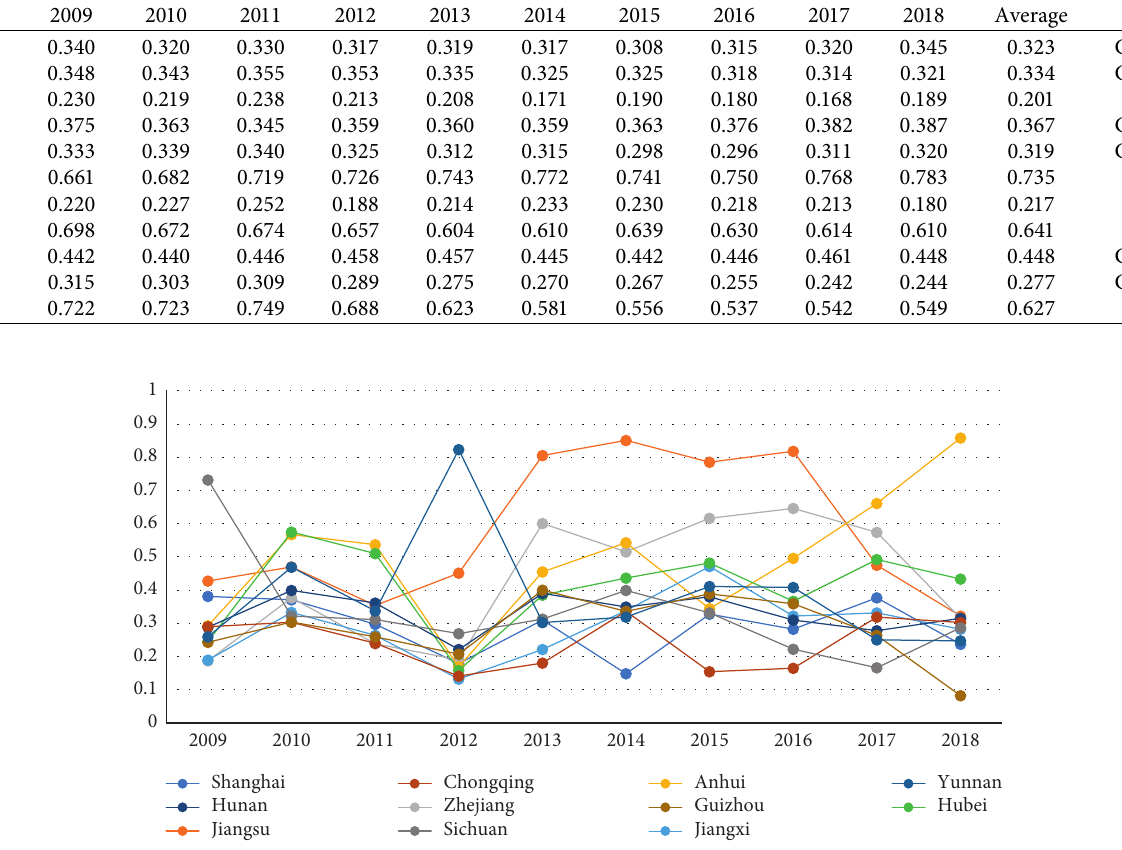
Figure 3: Temporal evolution of CDD for air